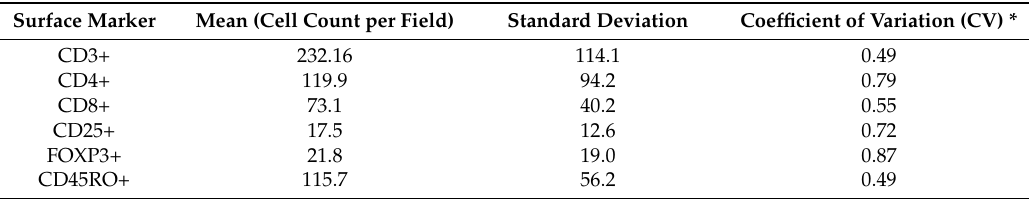
Table 3. Infiltration of T cell subtypes in 32 extrapeural pneumonectomy specimens. Surface